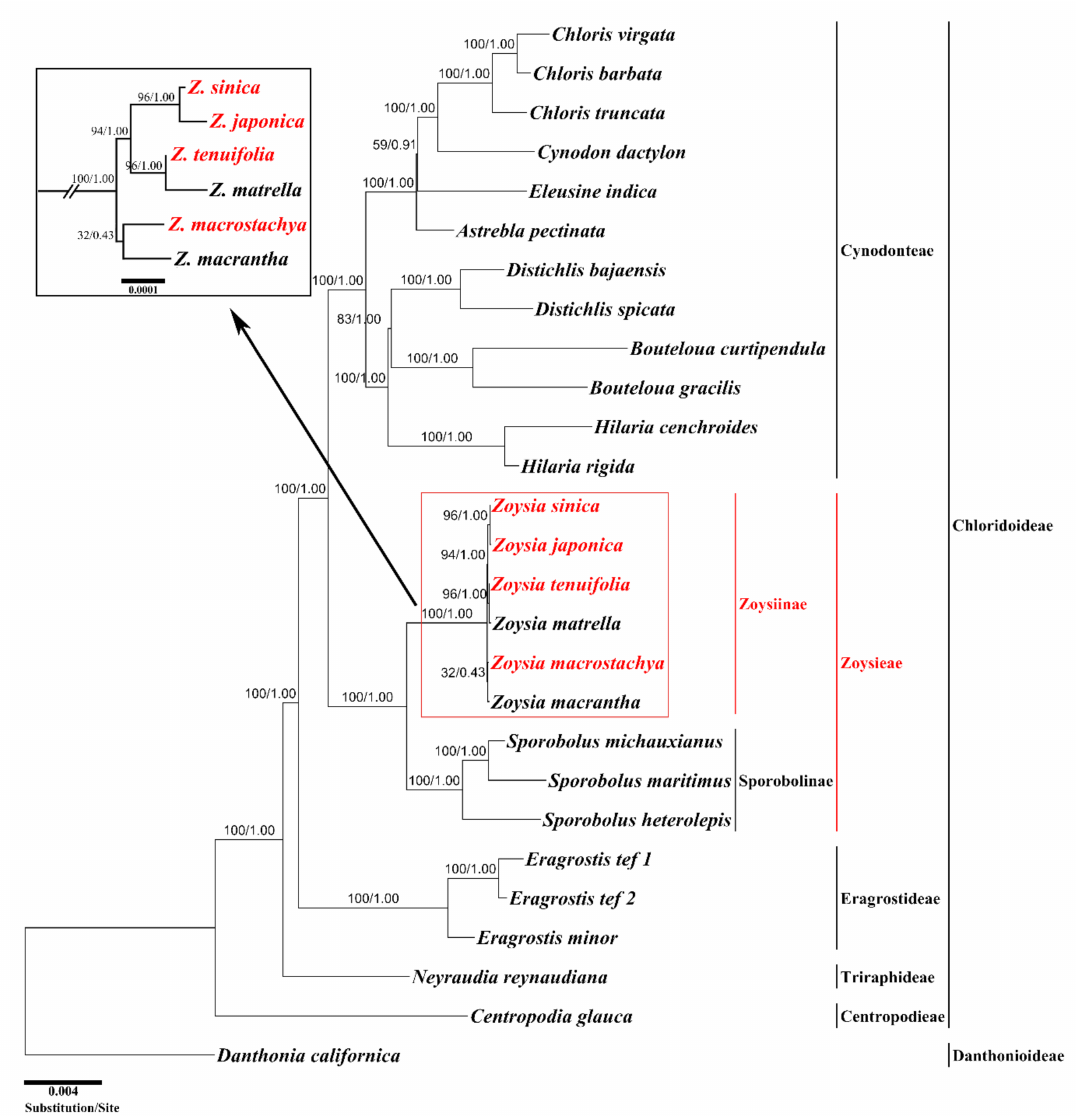
Figure 5. A maximum likelihood (ML) tree constructed from the plastomes of 26 species within the subfamily Chloridoideae (Poaceae) with Danthonia californica as an outgroup. The numbers at each node indicate the ML bootstrap values/Bayesian posterior probability. The ML tree was constructed from 76 protein-coding and 4 rRNA genes by RaxML. The newly sequenced species in this study are indicated in red. The short internal nodes among Zoysia species are expanded in the box at the upper left